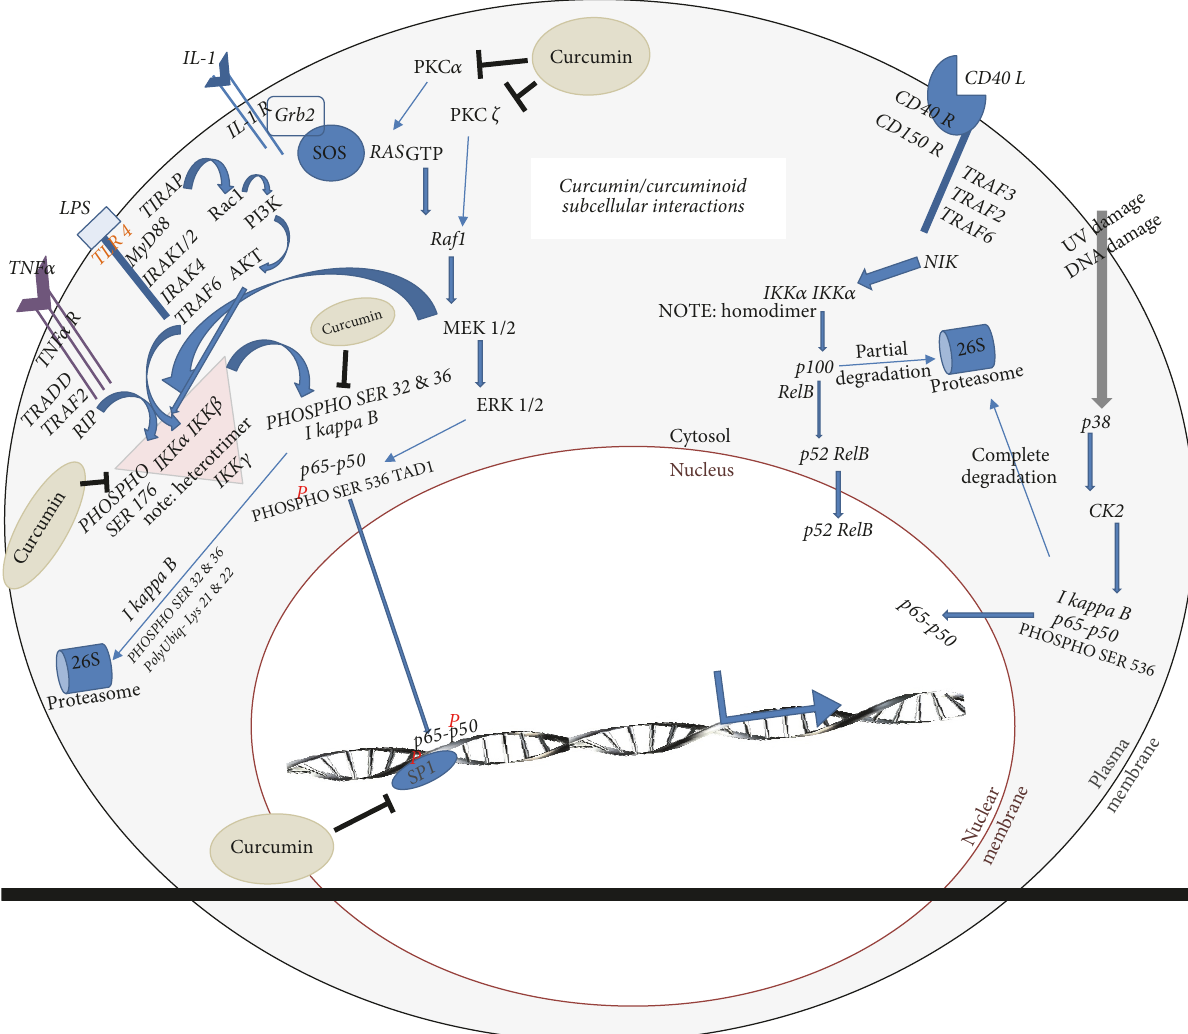
Figure 3: Curcumin polypharmacology plotted to show a rendered influence on p65-p50 transactivation potential showing a relatively more selective outcome if NF-kB is selected as the ultimate target of the